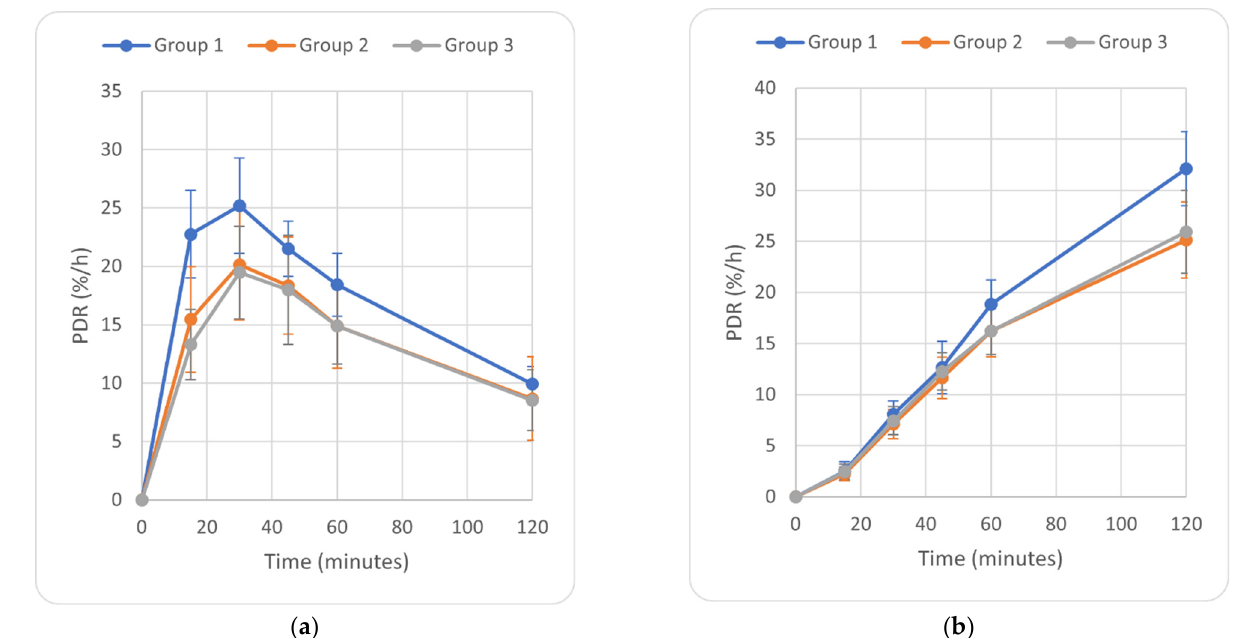
Figure 2. ( a ) PDR measurements; ( b ) cPDR measurements.